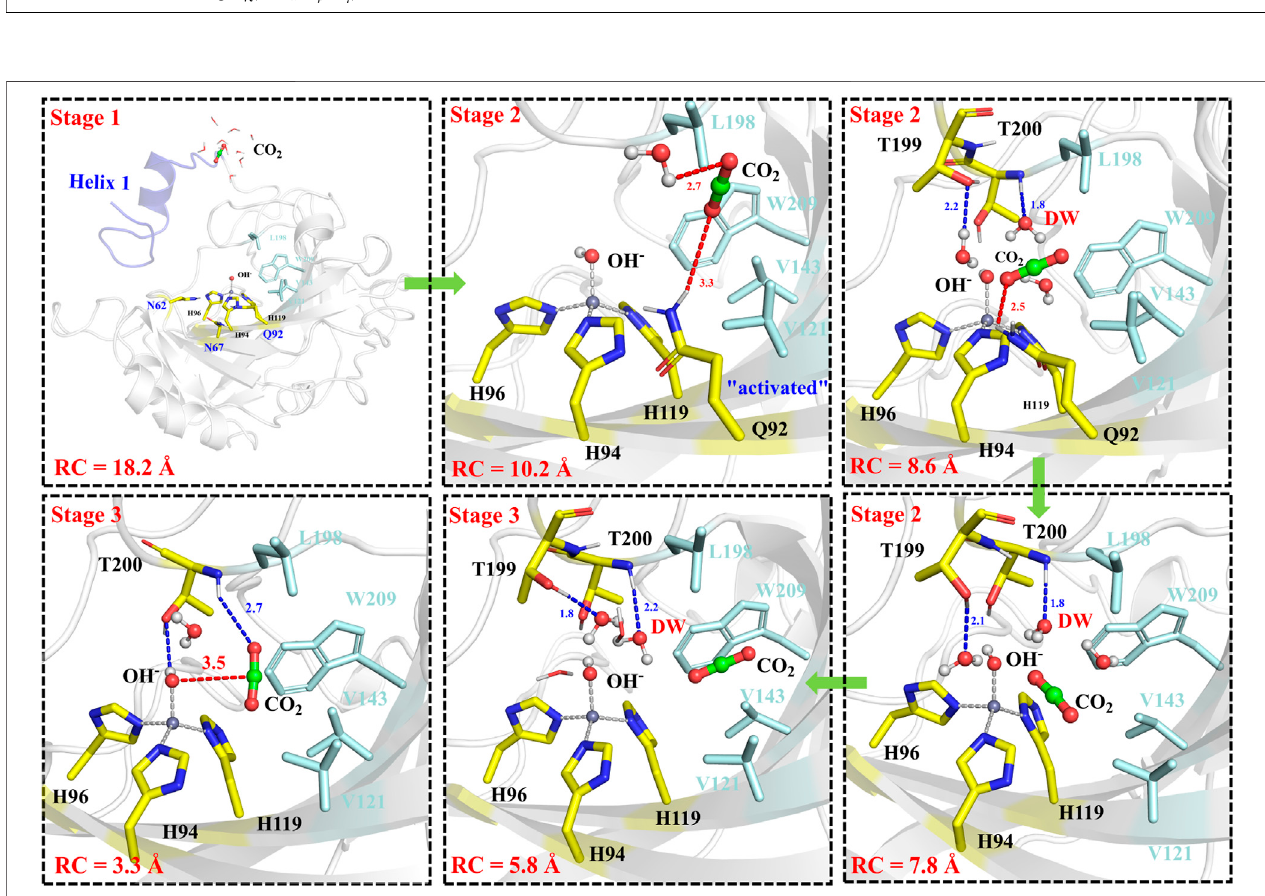
FIGURE 8 | Representative structures and conformational changes for the delivery of CO 2 , where the reaction coordinate is de fi ned as the distance between W209@CH2 and